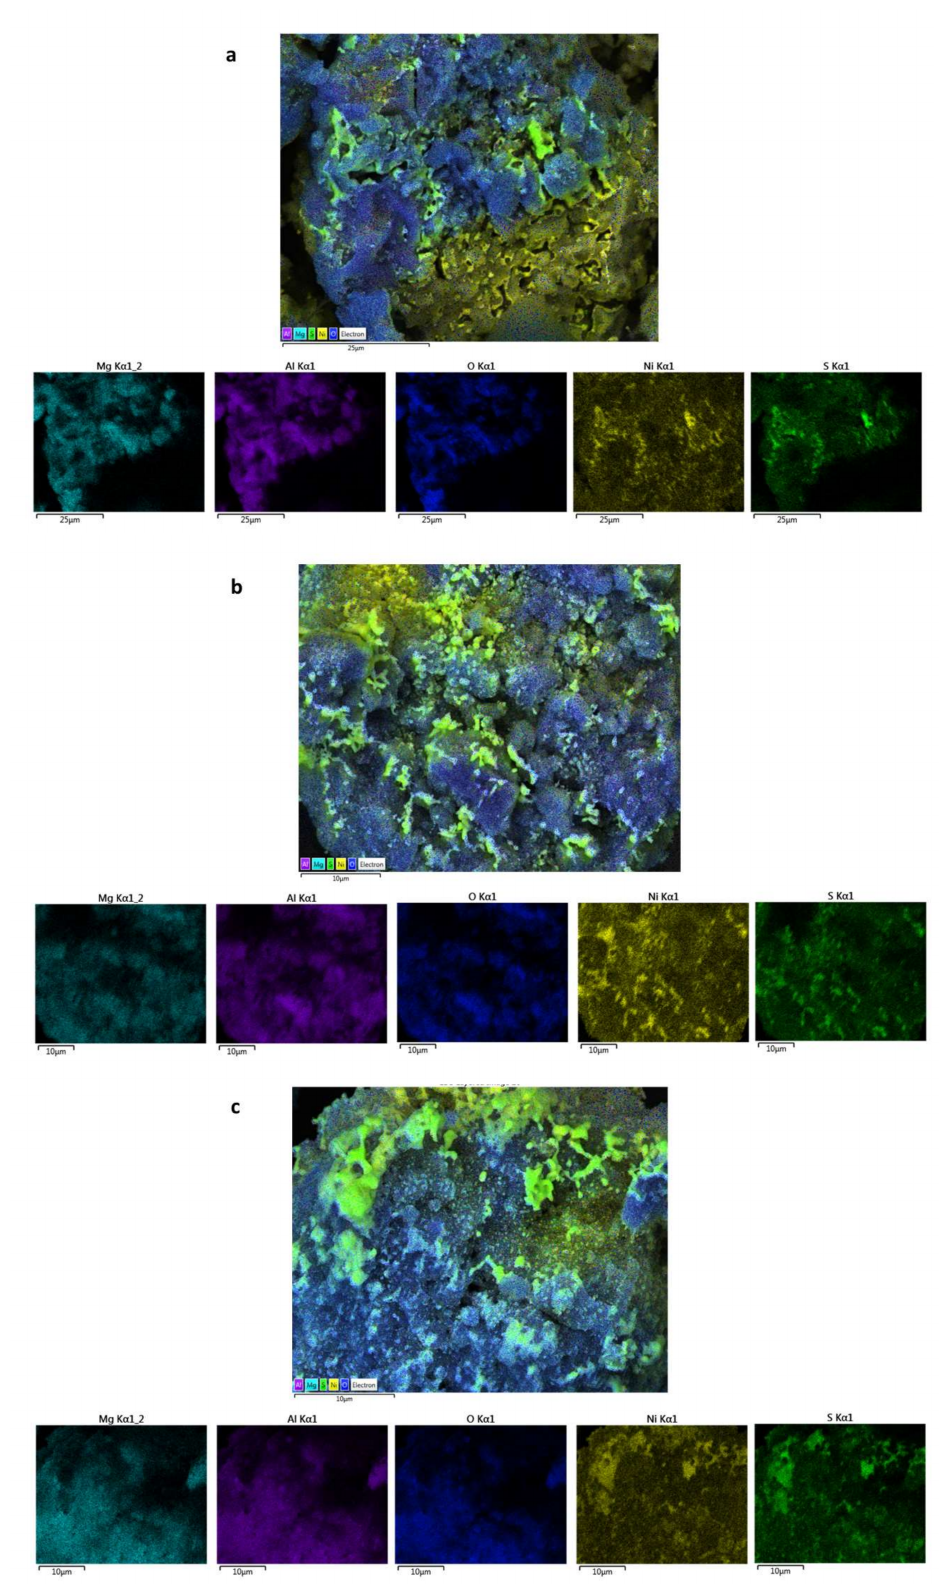
Figure 5. X-ray mapping of ( a ) Ni/MgAl 2 O 4 -S2-200, ( b ) Ni/MgAl 2 O 4 -S2-400 and ( c ) Ni/MgAl 2 O 4 -